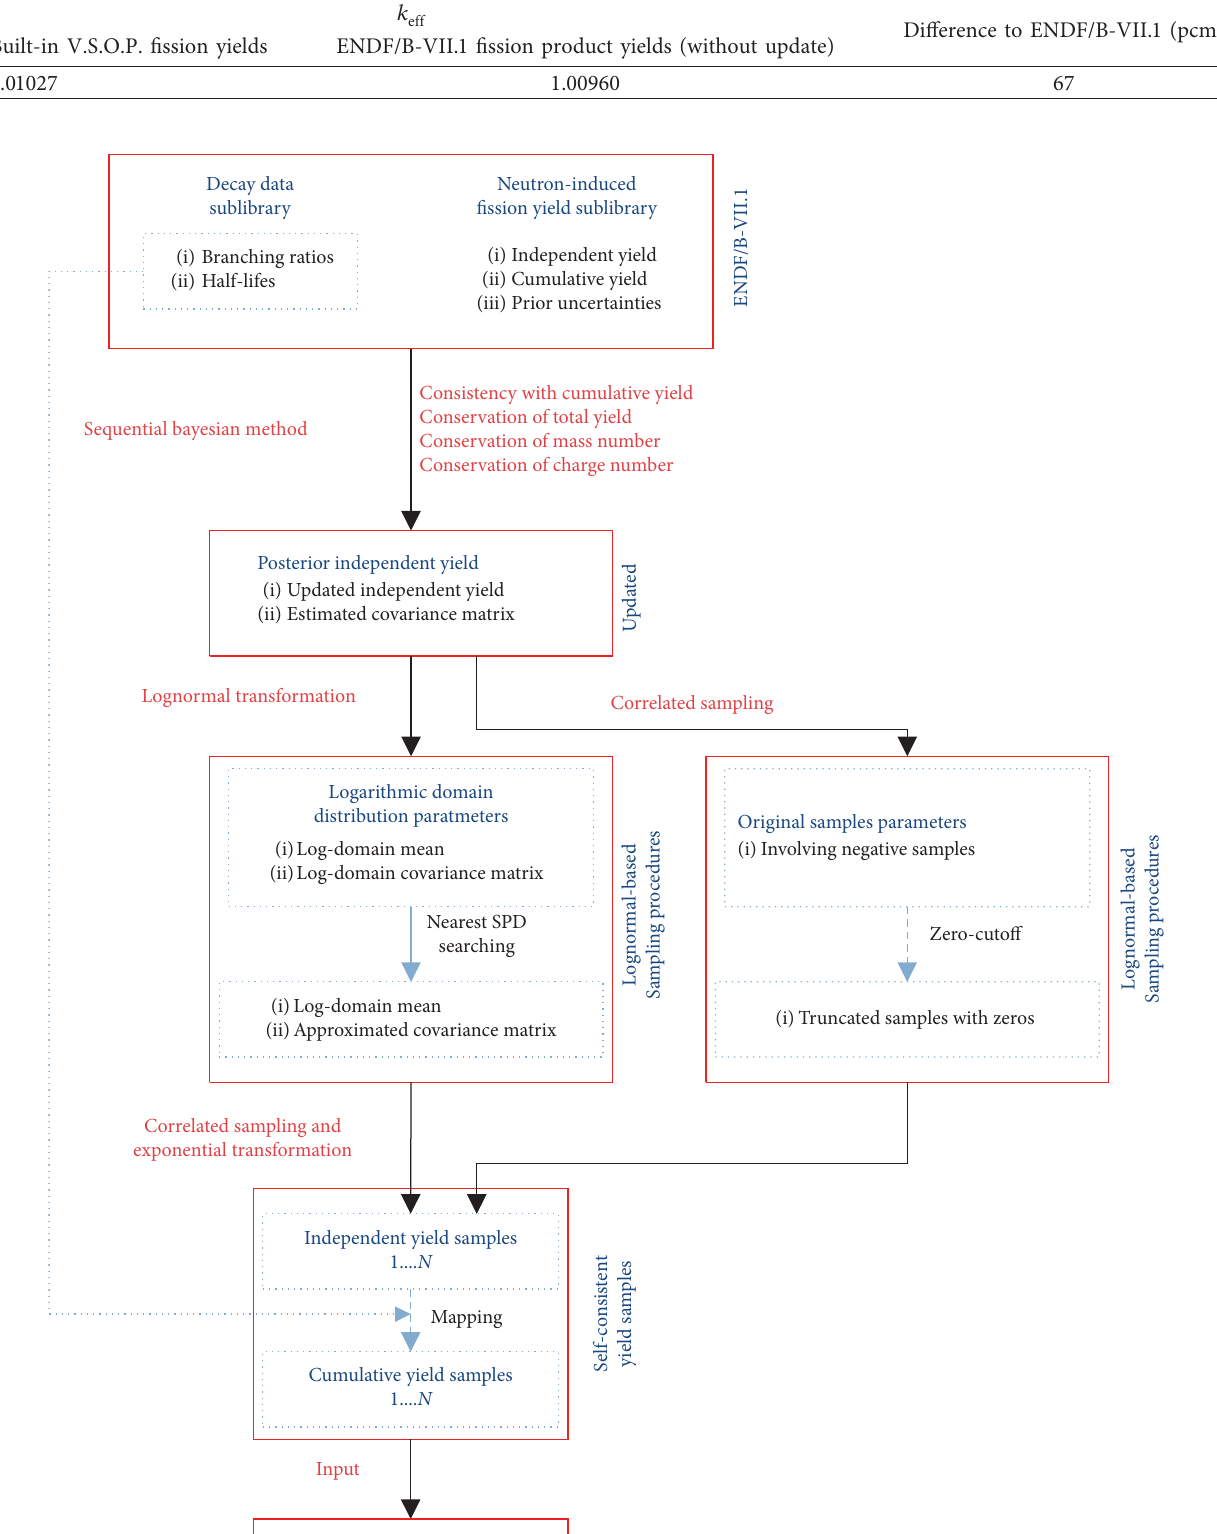
Table 3: Reference calculation between built-in fission yields of V.S.O.P. and ENDF/B-VII.1 (all substitution without FP-44).